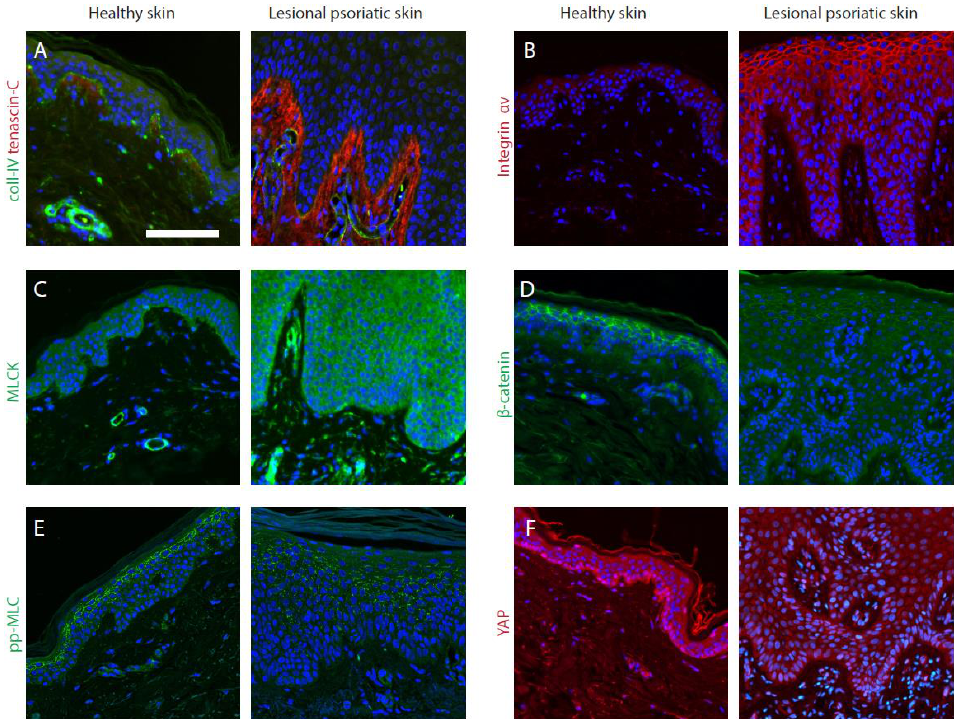
Figure 3. Dysregulation of mechanotransduction-related proteins in psoriatic skin revealed by immunofluorescence. ( A ) Collagen IV is generally lost from the BM and tenascin-C is overexpressed in the dermis of psoriatic skin. ( B ) Integrin αv is upregulated in the dermis. ( C ) In normal skin, MLCK has higher expression in the basal layer of the epidermis, whereas in psoriatic skin, it is increased in all epidermal layers. ( D ) β -Catenin is downregulated at the epidermal cell junctions. ( E ) The phosphorylated myosin light chain (Thr18/Ser19) underlies the cell borders in the upper epidermal layers in normal skin and the continuous pattern is lost in psoriatic epidermis. ( F ) YAP localizes to the nucleus in the basal layer, but not in the upper layers in the normal epidermis, whereas its nuclear localization is retained in multiple layers of a psoriatic epidermis. DAPI is in blue. Scale bar, 100 μ m.